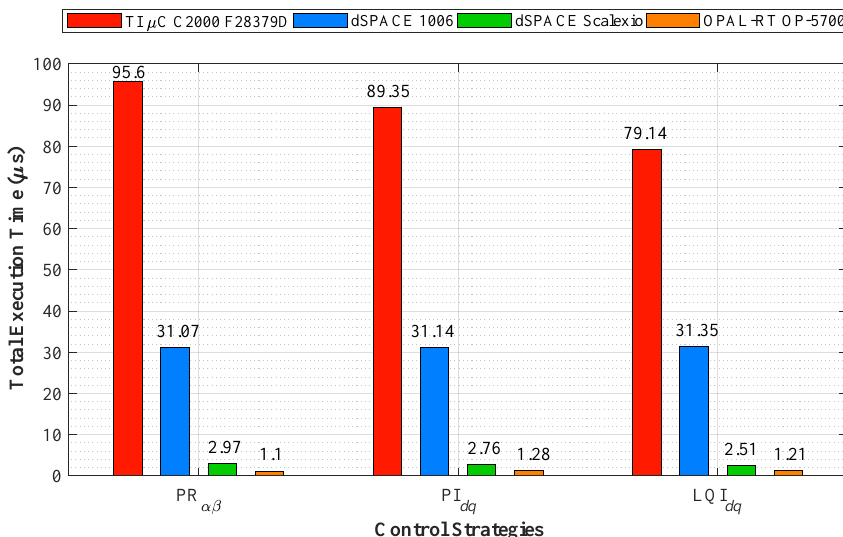
Figure 18. Time profiling for full block controllers.